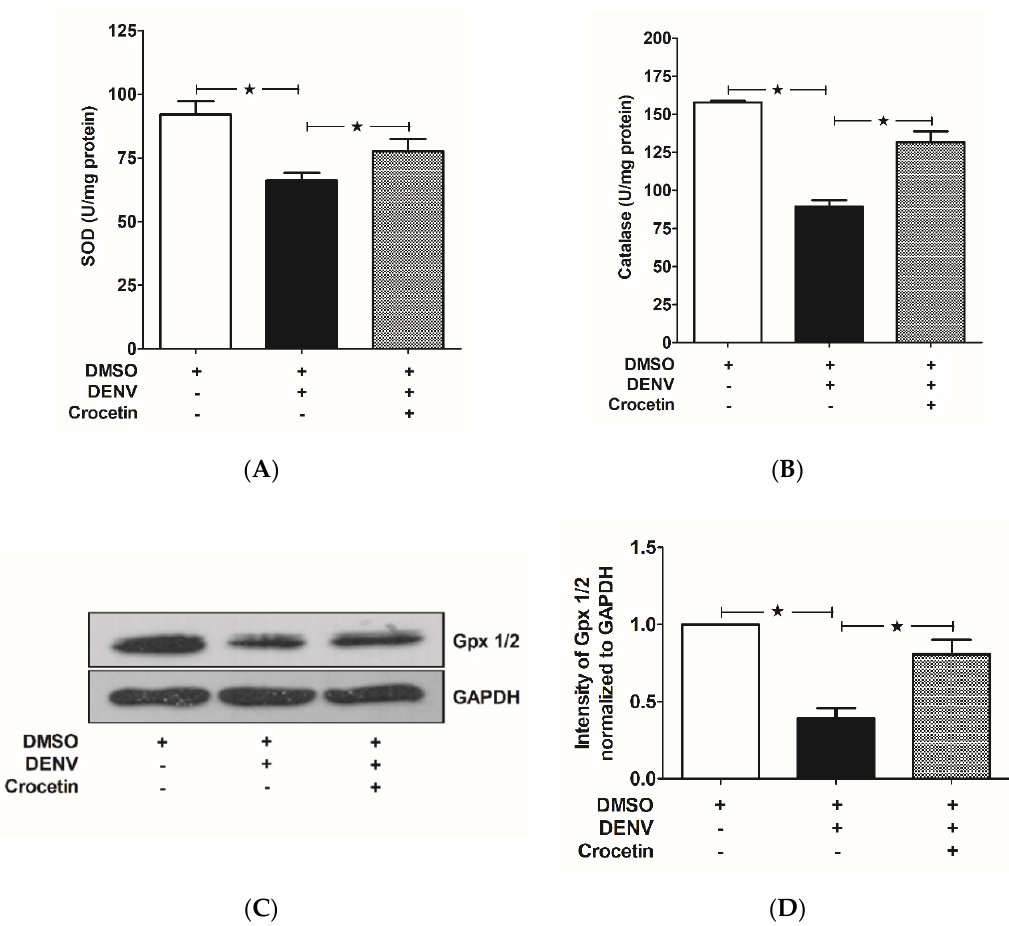
Figure 5. Crocetin reduced oxidative stress in the livers of DENV-infected mice. BALB/c mice were infected with DENV-2 (4 × 10 5 FFU/mL) and then treated with crocetin (50 mg/kg) dissolved in 2% DMSO. DENV-infected 2% DMSO-treated and mock-infected 2% DMSO-treated groups of mice were used as positive and negative controls, respectively. For the antioxidant enzyme (SOD and catalase) activity assay, protein samples were prepared from liver homogenates using standard protocols. SOD and catalase absorbance were read at 450 nm and 570 nm, respectively. For the expression of Gpx 1/2, Western blot analysis was conducted on protein samples obtained from liver homogenates, and the blots obtained were quantitated by ImageJ densitometry analysis. The results are given as follows: ( A ) SOD activity, ( B ) Catalase activity, ( C ) Gpx 1/2 expression, and ( D ) Densitometry analysis of Gpx 1/2 expression. The black star represents, those groups were compared and found to be significant.